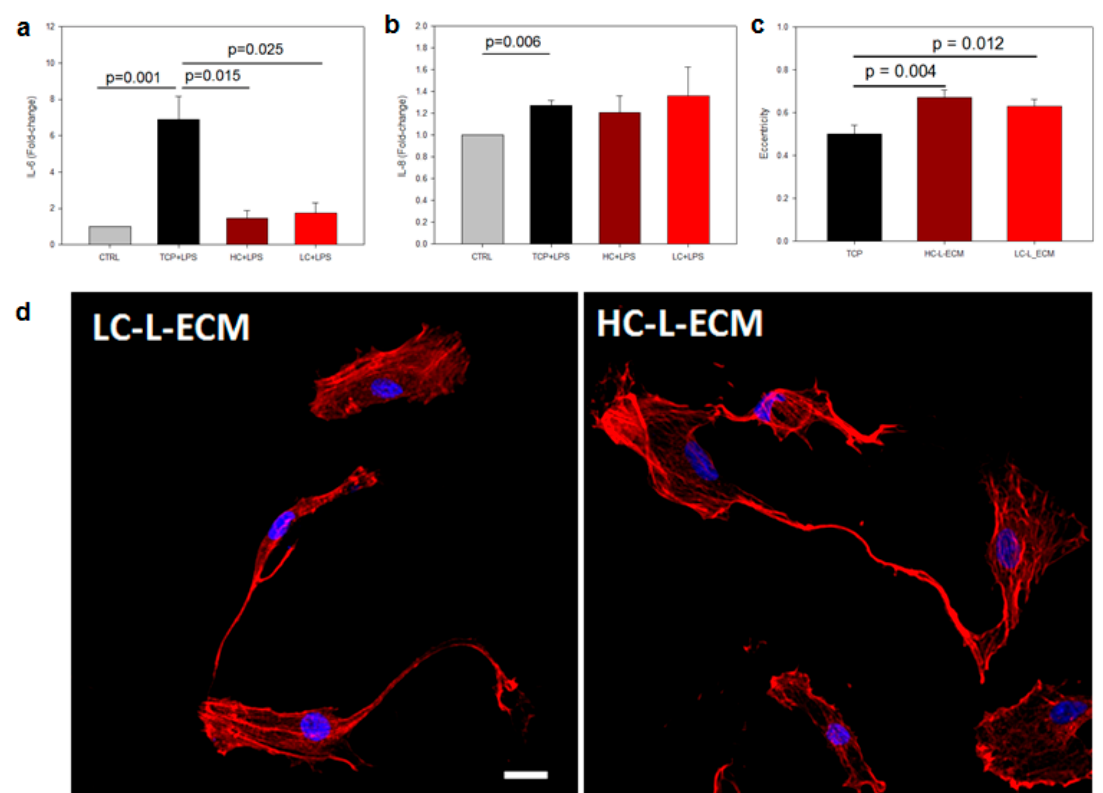
Figure 4. Immunomodulatory potential of MSCs. ( a , b ) Enzyme-linked immunosorbent assay (ELISA) quantification of the secretion of interleukin-6 (IL-6) and IL-8 cytokines in the co-cultures of L-MSCs and small airway epithelial cells (SAECs) after lipopolysaccharides (LPS) challenge. Mean ± SE, n = 5 ( c ) Quantification of cell eccentricity to characterize their morphology. Mean ± SE, n = 20 ( d ) Representative images for the actin (red) and nuclei (blue). Scale bar: 10 µm.